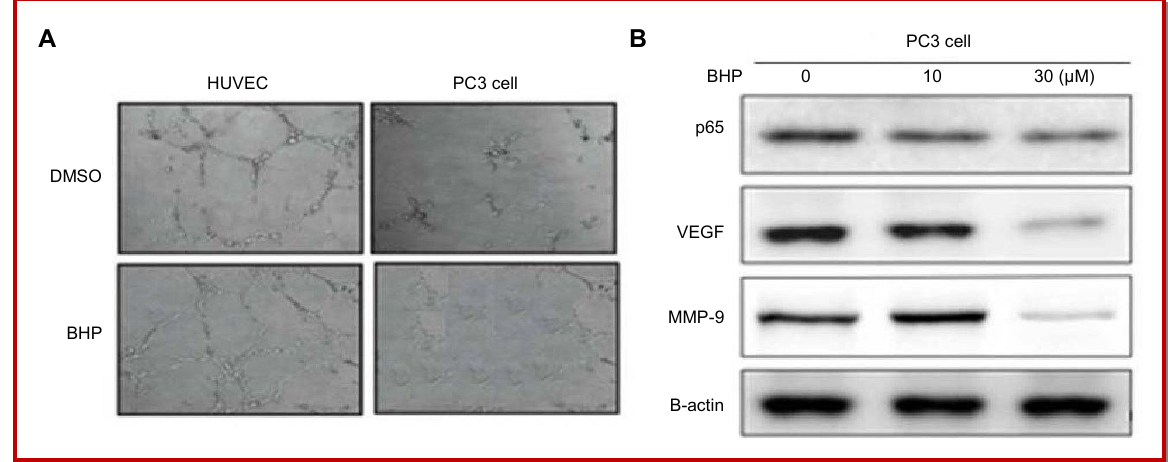
Figure 4: BHP exposure inhibited HUVEC tubulogenesis and PC3 cell invasion. (A) BHP influences tube formation by the endo- thelial cells through involvement of angiogenic factors in PC3 cells. PC3 cells cultured in the presence of BHP on matrigel pre- coated transwells plates for 24 hours showed inhibition in invasive ability on matrigel. (B) PC3 cells exposed to BHP for 24 hours showed inhibition in the expression of p65, VEGF and MMP-9 by immunoblot